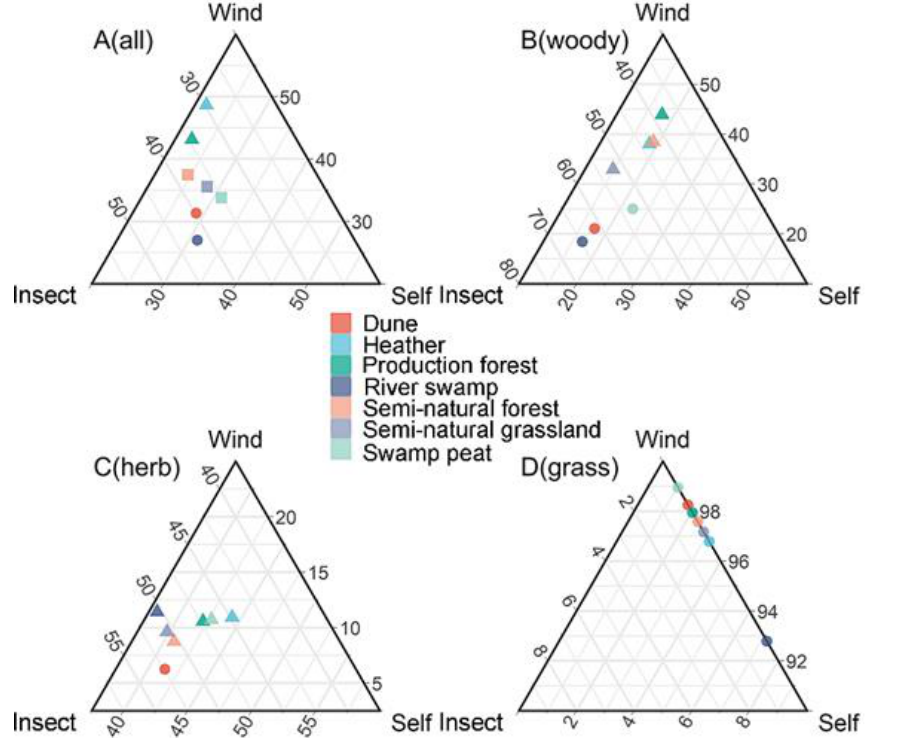
Figure 2. Percentages of species with different pollination modes in each of seven habitat types for (A) all plants, (B) woody species, (C) herbs and (D) grasses. In this ternary graph, different colours indicate different habitat types and different shapes mean statistically different clusters (cluster analysis by compositions ). The average number of species in each habitat type can be found in Appendix